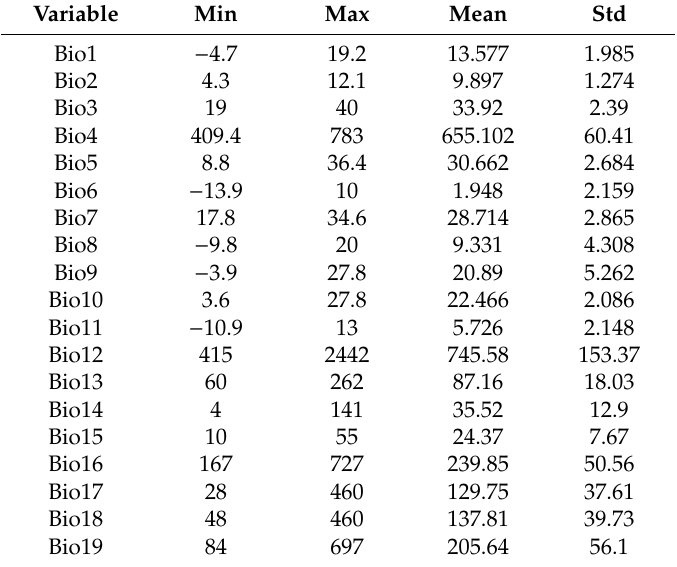
Table A2. 19 Bioclimatic variables of 2050 RCP4.5 scenario (see Figure 1 for variables